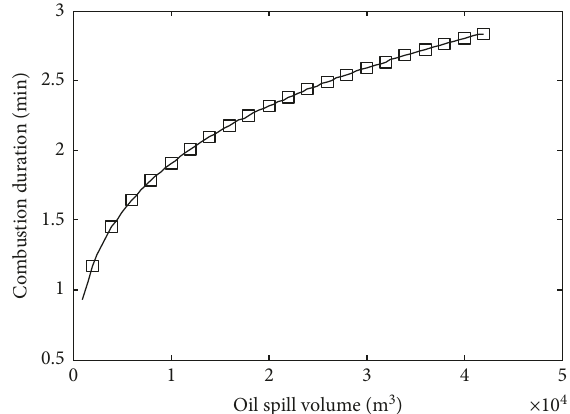
Figure 3: The burning duration t c versus the volume of burning oil spill on sea surface under combined action of spreading and combustion.